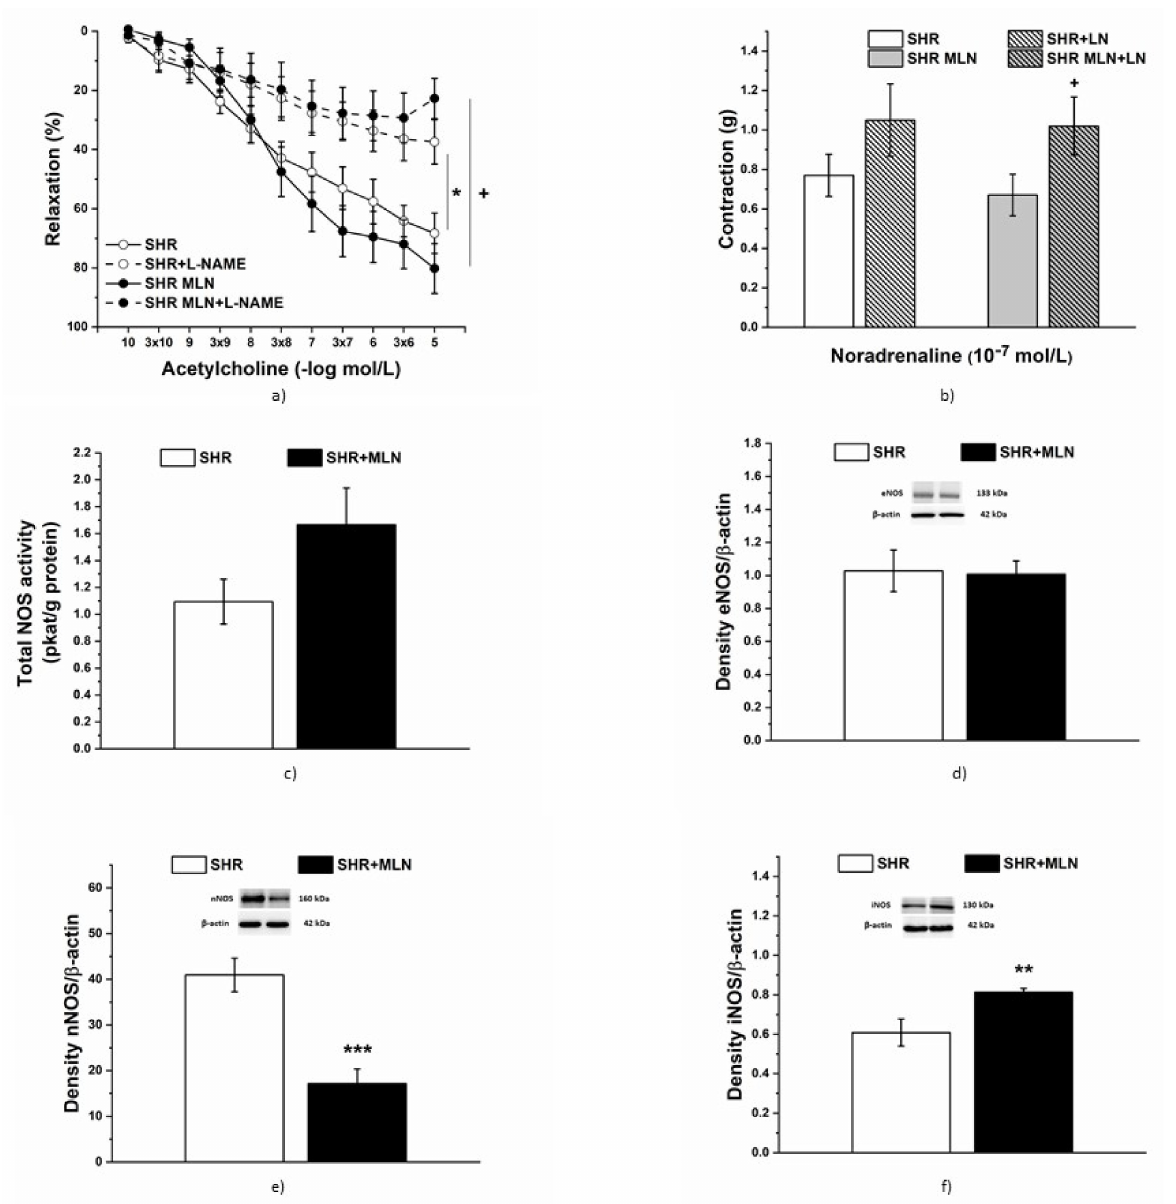
Figure 6. The effect of acute NO synthase (NOS) inhibition on endothelium-dependent vasorelaxation ( a ) and the contractile response ( b ) of TA isolated from control SHRs and SHRs treated with MLN- 4760. The total NOS activity ( c ) and the protein expression of endothelial eNOS ( d ), neuronal nNOS ( e ) and inducible iNOS ( f ) were measured in aortic tissue. The results are presented as the mean ± S.E.M., and differences between groups were analyzed by three-way ANOVA or Student’s t -test, as appropriate, * p < 0.05, ** p < 0.01 vs. SHR, *** p < 0.001 vs. SHR; + p < 0.05 vs. SHR +